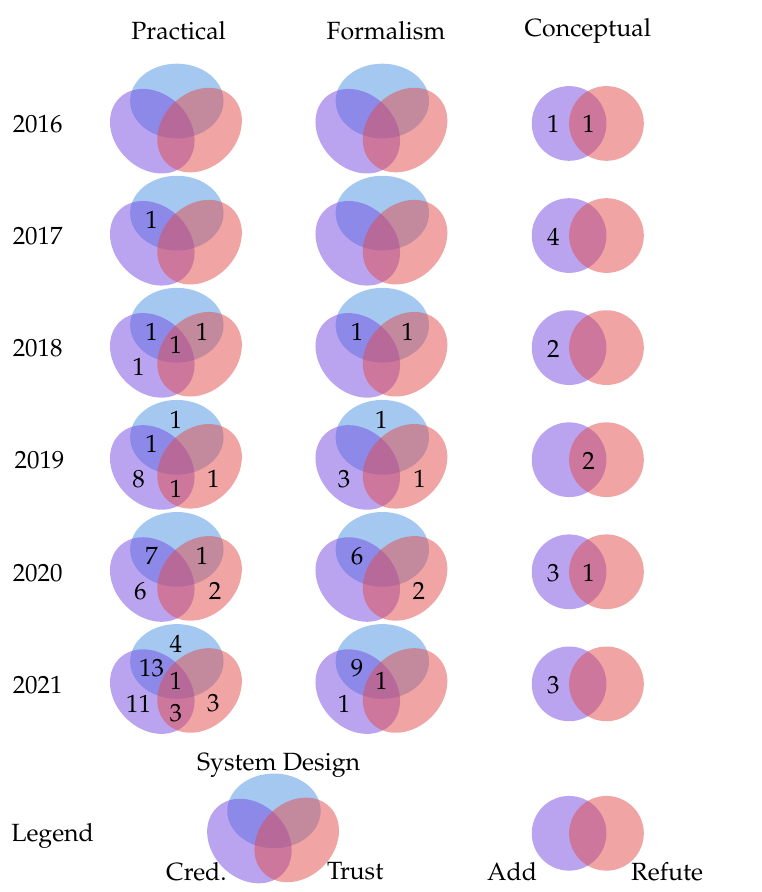
Figure 5. The number of publications in each facet of our taxonomy over time.